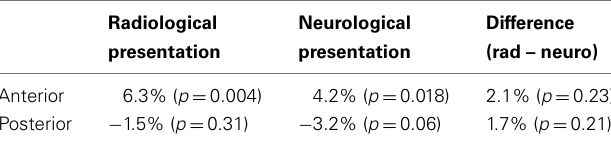
Table 3 | Measured asymmetry index did not depend strongly on image